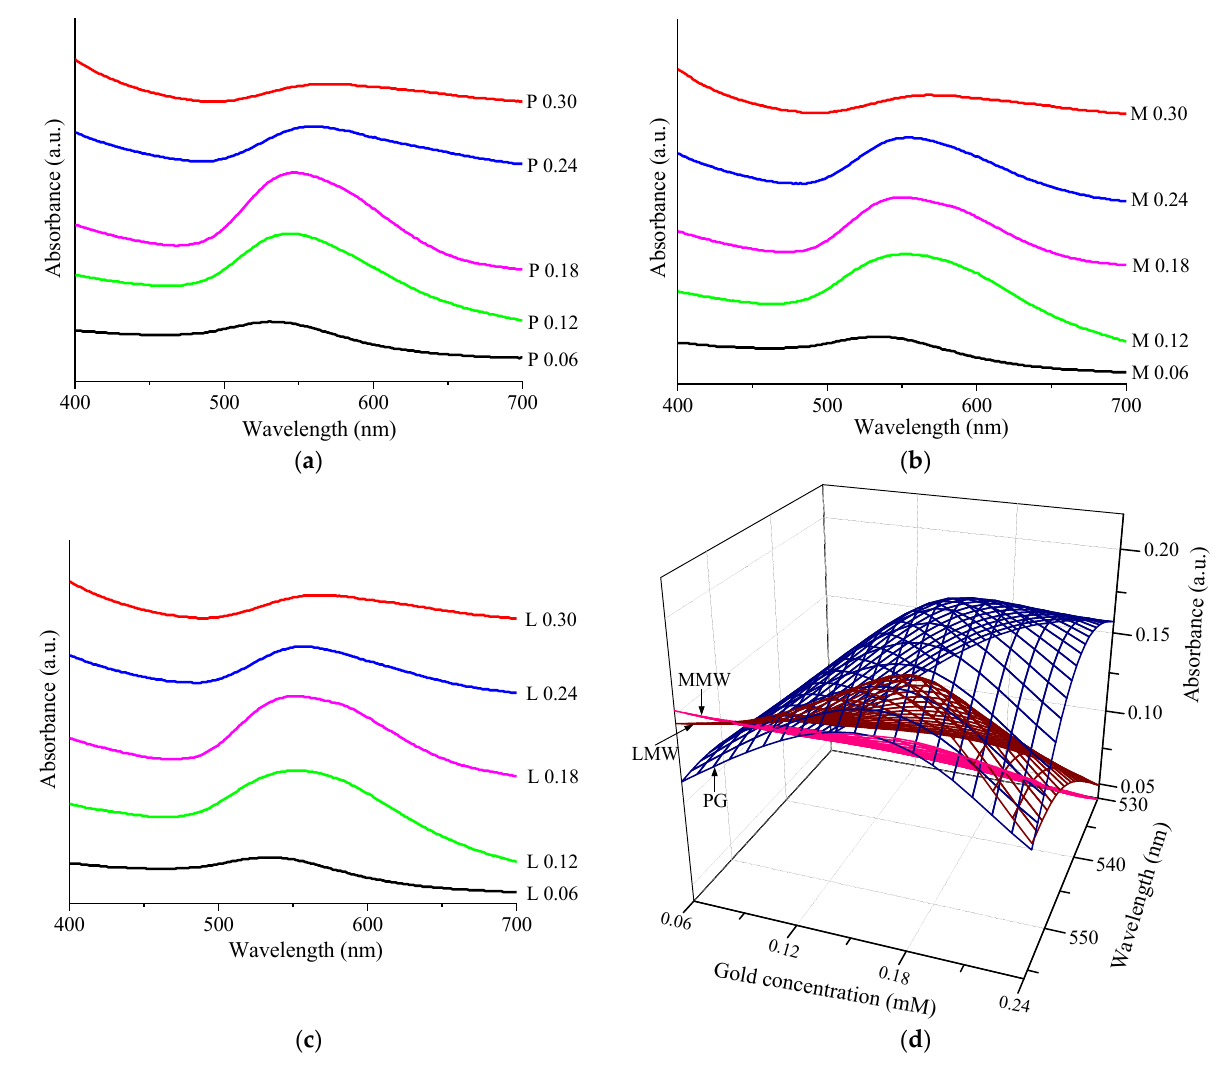
Figure 7. UV-Vis measurements: ( a ) UV-Vis spectra of PG samples; ( b ) UV-Vis spectra of MMW samples; ( c ) UV-Vis spectra of LMW samples; ( d ) the dependencies presented in Table 5. Table 5. The maximum plasmon resonance band values of the AuNPs as a function of gold concen- tration and type of chitosan.